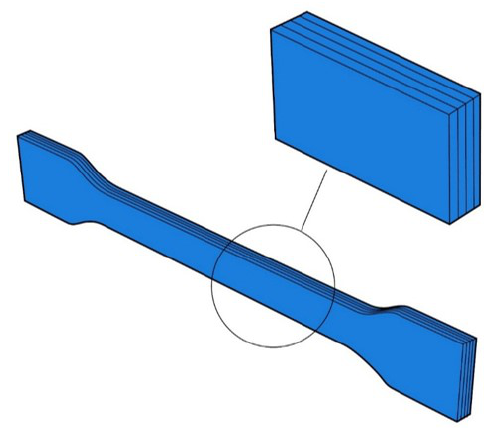
Figure 5. Simulation model with 4 layers.